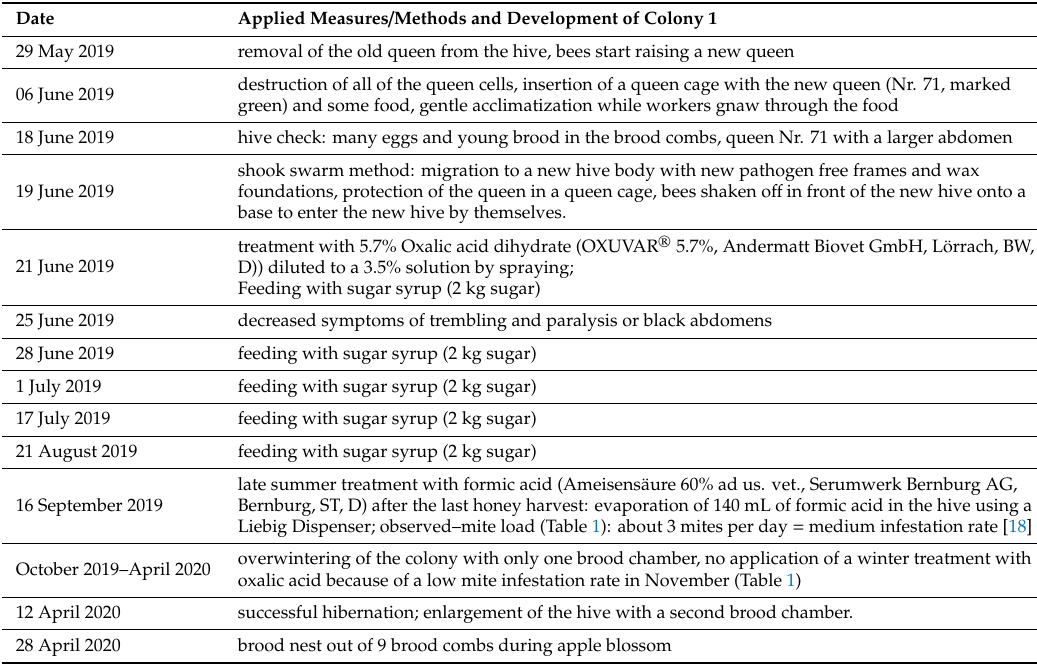
Table 4. Therapeutic measures and outcome of colony 1 after diagnosis of an overt CBPV infection.